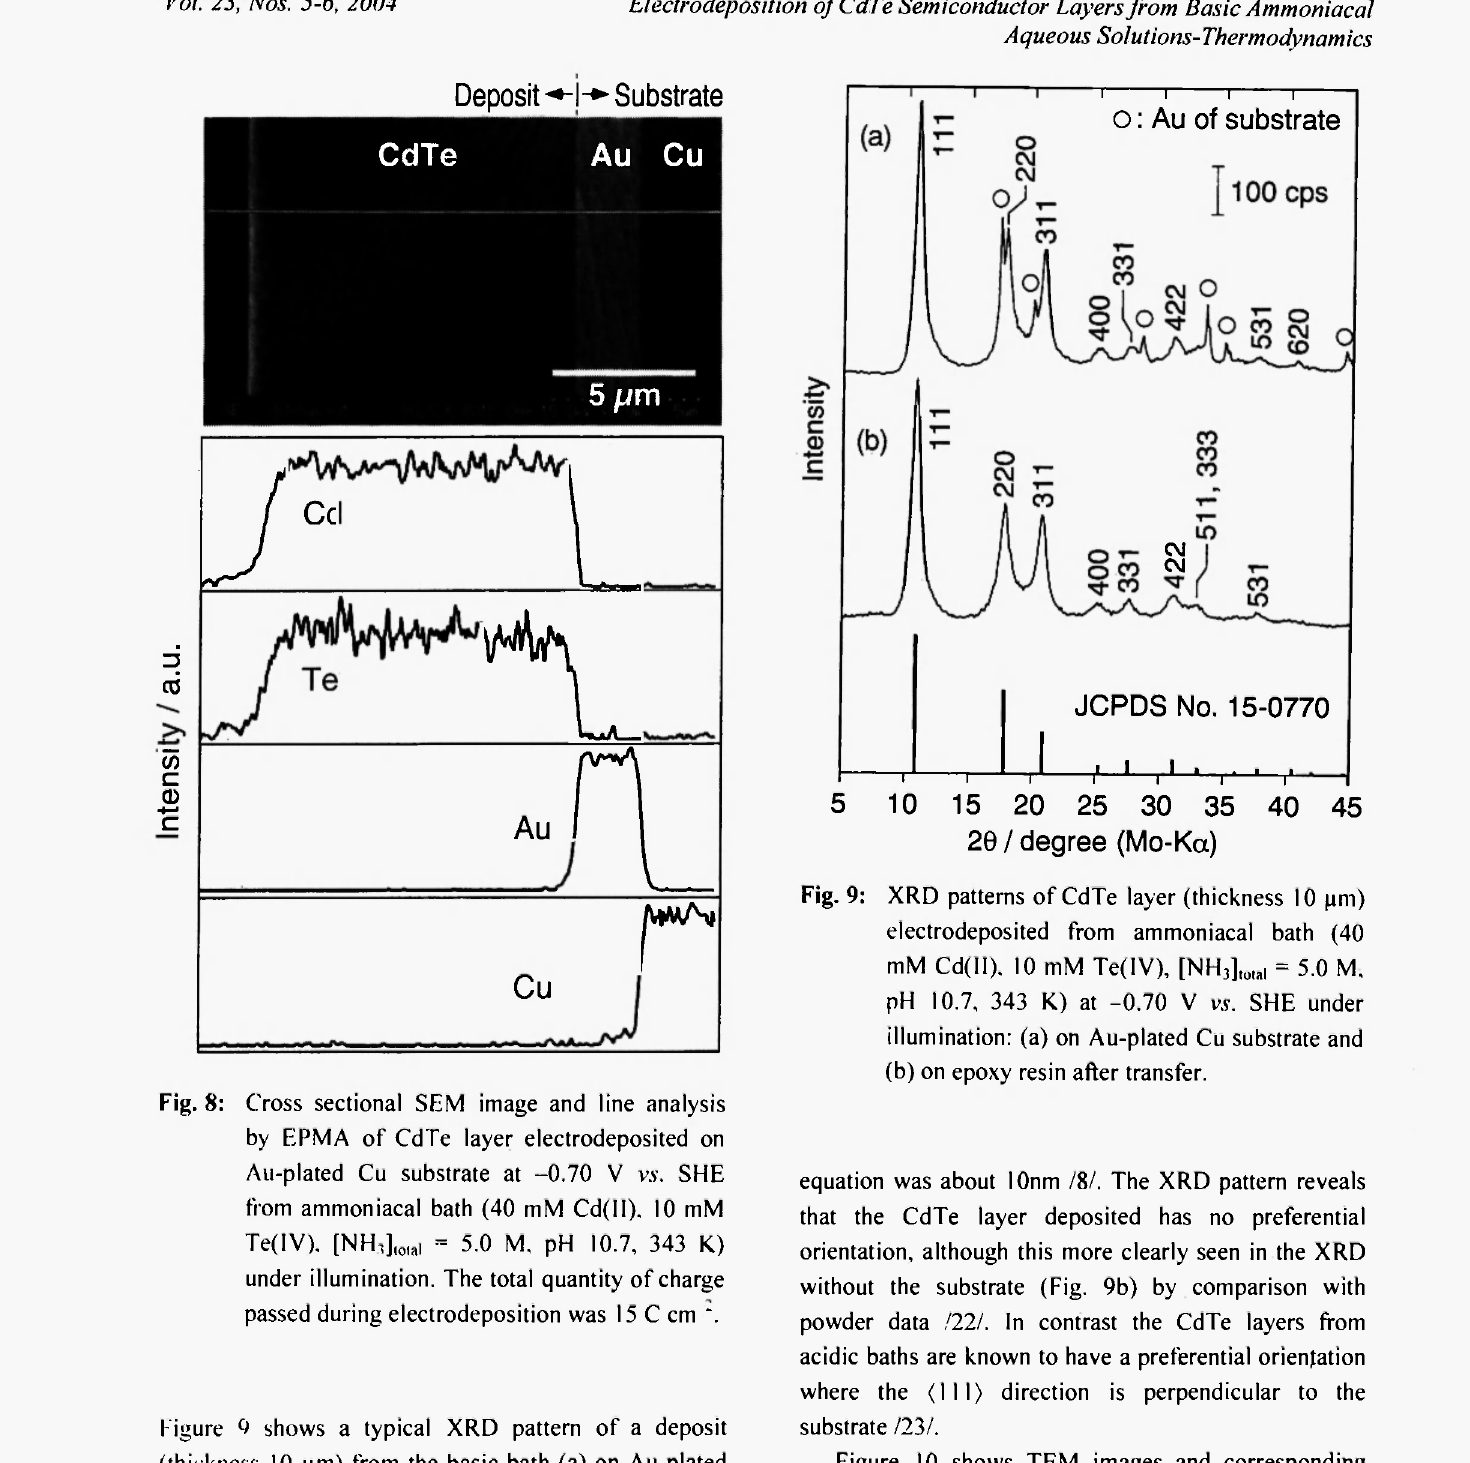
Fig. 8: Cross sectional SEM image and line analysis by ΕΡΜΑ of CdTe layer electrodeposited on Au-plated Cu substrate at -0.70 V v.s\ SHE from ammoniacal bath (40 mM Cd(II). 10 mM Te(IV). [NH,] I01J | - 5.0 M, pH 10.7, 343 K)